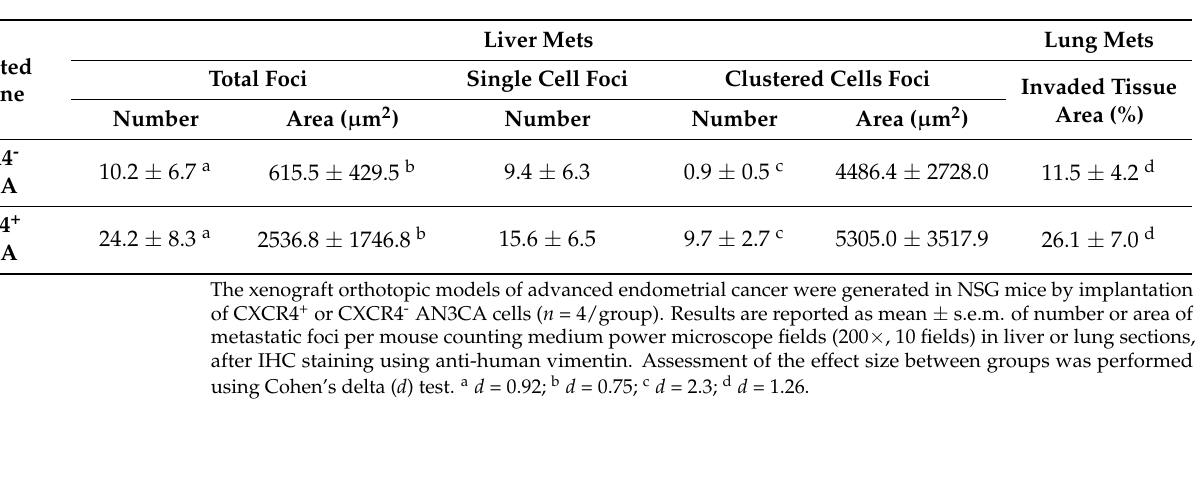
Table 1. Comparison of metastatic dissemination in advanced endometrial cancer orthotopic models derived from CXCR4 + or CXCR4 - AN3CA